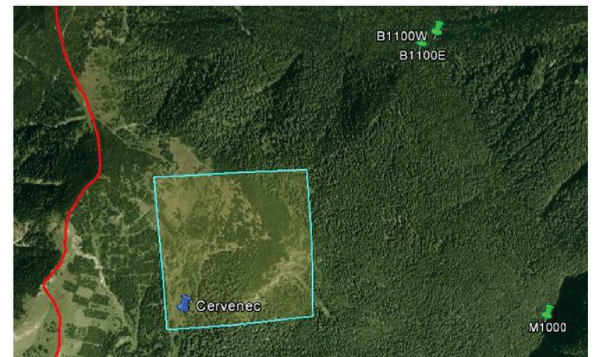
Fig. 3. Location and vegetation coverage near ˇCervenec station (screenshot from Google Earth). The blue polygon indicates the size and position of the MODIS